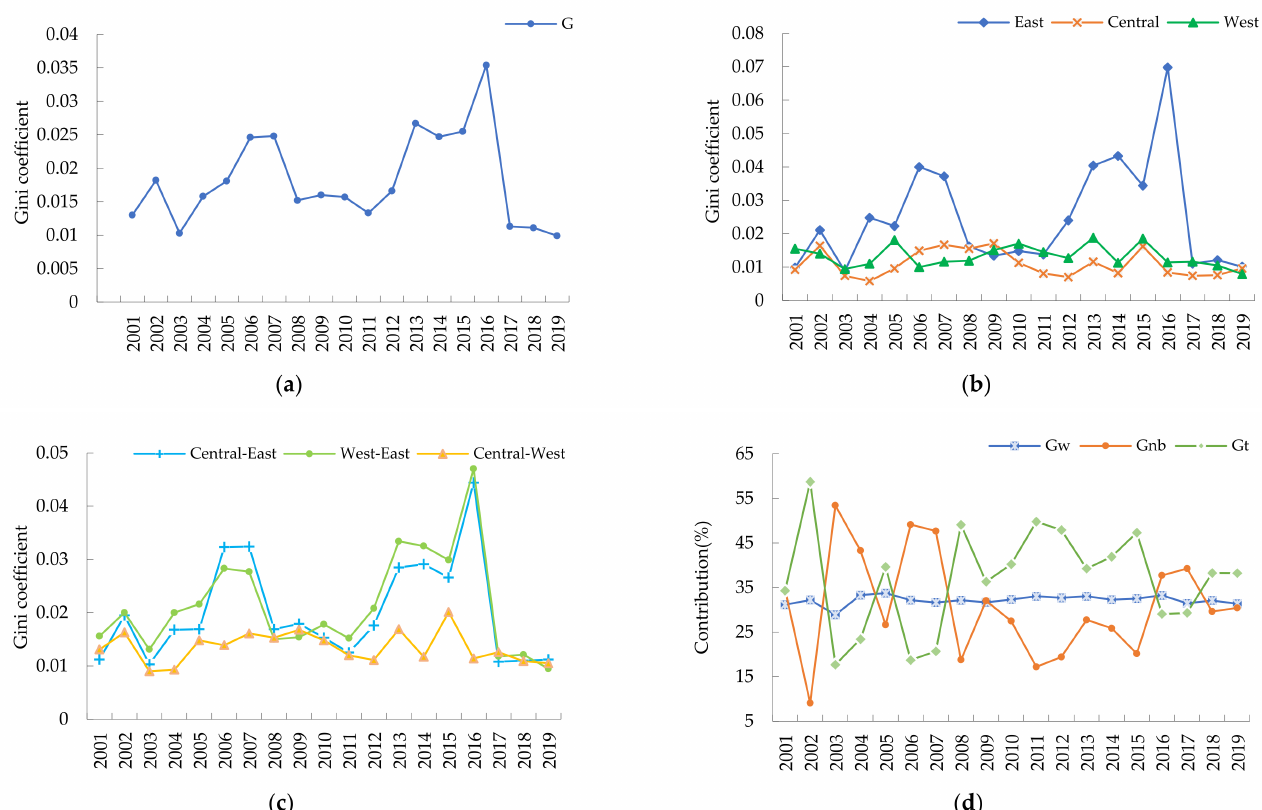
Figure 2. The trends of the Dagum Gini coefficient of GTI in China. ( a ) The overall Gini coefficient of the GTI in China. ( b ) The intra-regional differences of the GTI. ( c ) The inter-regional differences of the GTI. ( d ) The evolution of the contribution